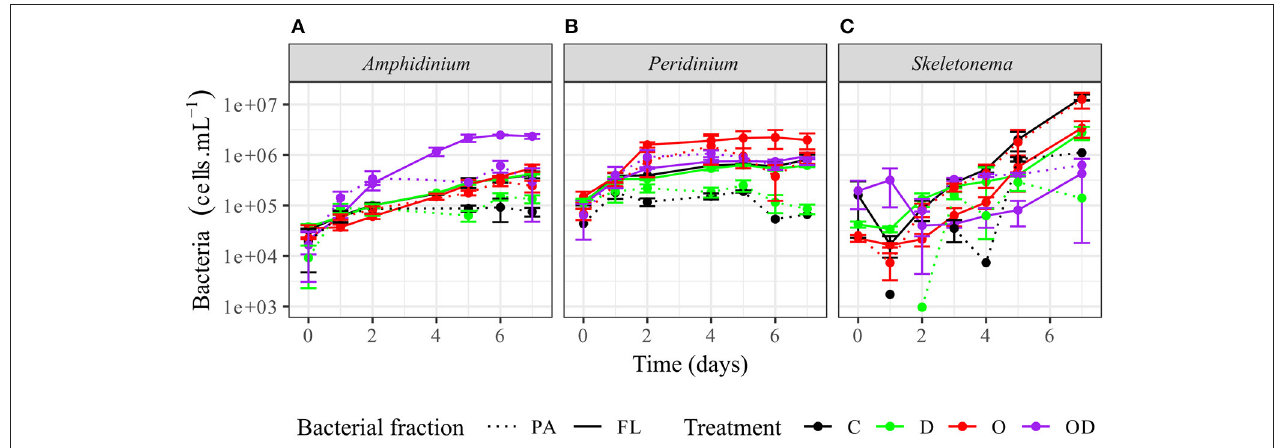
FIGURE 2 | Abundance of the phytoplankton-attached (PA, dashed line) and free-living (FL, solid line) bacteria in (A) A. carterae , (B) P. sociale, and (C) Skeletonema sp. cultures for each treatment. Controls are shown in black, dispersant alone in green, oil alone in red, and dispersed oil in purple. The error bars represent the standard deviation of the